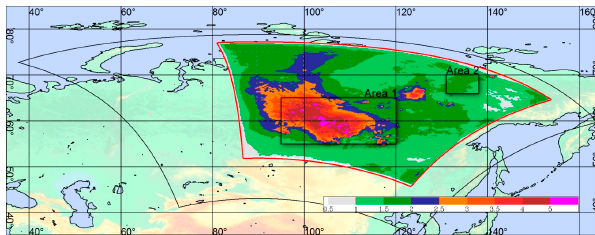
Figure 4. Modeled aerosol optical depth over the modeling domain, averaged from 1–14 August 2019.